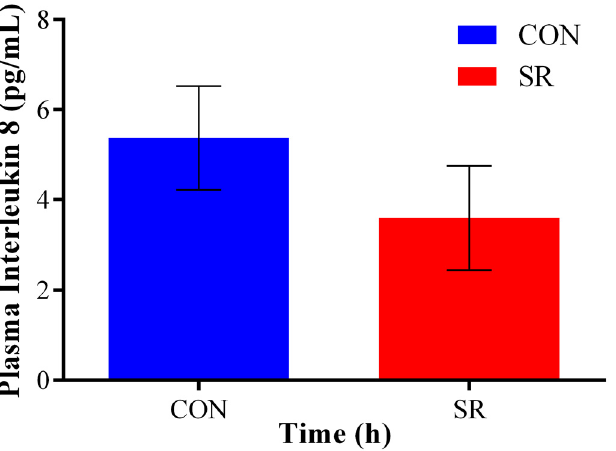
Fig 2. Predicted REML means for significant fixed effect of condition for IL-8 level in CON and SR conditions. Data was log-transformed prior to analysis. For ease of interpretation, values were back transformed to